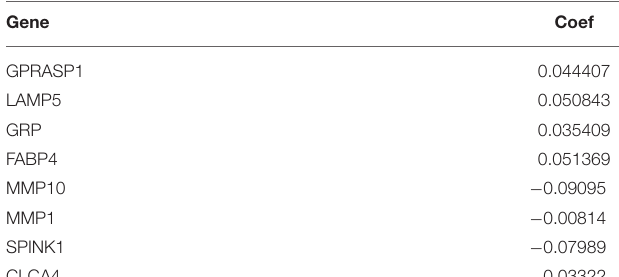
TABLE 1 | Correlation coefficients of 8 key genes in necroptosis signature.